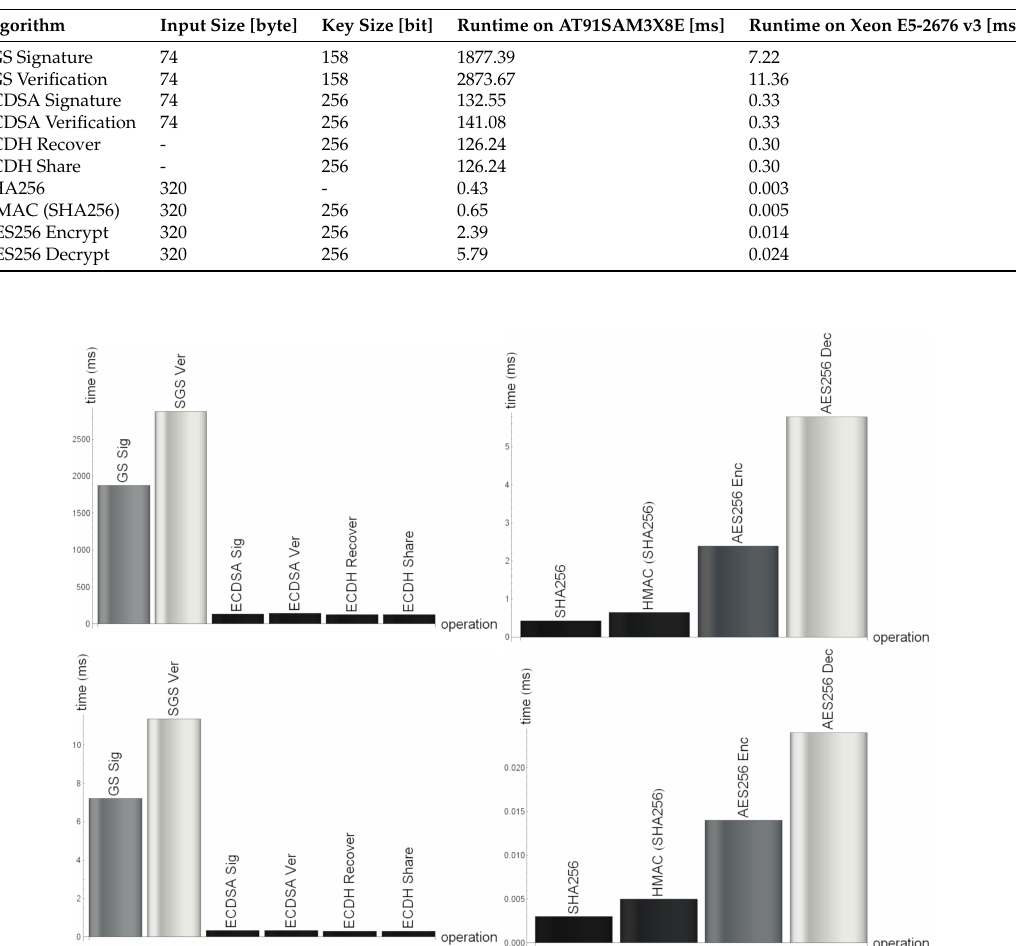
Table 3. Cryptographic algorithms runtime analysis.